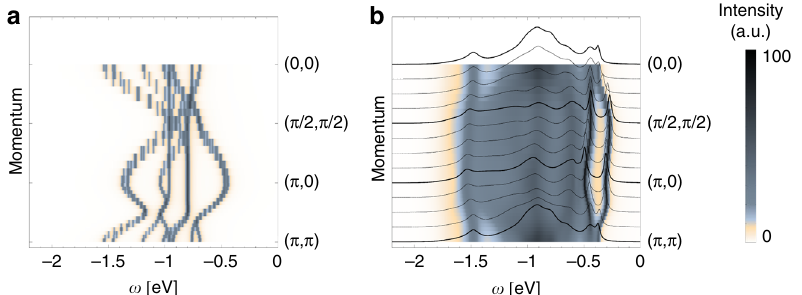
Fig. 3 Free and polaronic contributions to the spectrum. a Theoretical photoemission spectral function with only propagation of the hole not coupled to magnons allowed as achieved by setting ^ V α k ¼ ^ V β k (cid:2) 0. b Theoretical photoemission spectral function with only polaronic propagation via coupling to magnons allowed (i.e., no free dispersion) as achieved by setting ^ V 0 k (cid:2) 0. Parameters as in Fig. 2